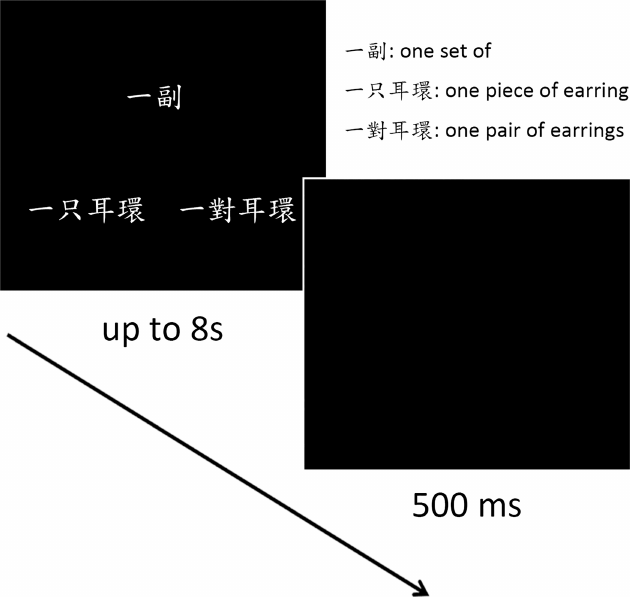
Fig 1. The experimental procedure. In each trial, participants saw three C/M phraseson the screen. They had to choose betweenthe two C/M phrasesat the bottom the one that was semanticallycloser to the target C/M phraseon the top. The C/M options were composedof minimalpairs which includedan identicalnumeral, a classifier or a measureword, and an identicalnoun.